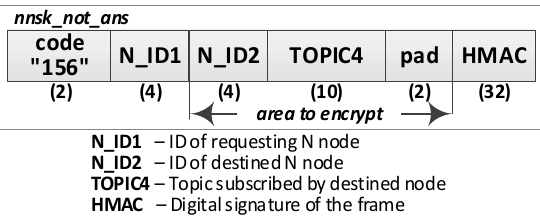
Figure 26. The response to frame of notification about the new session key.